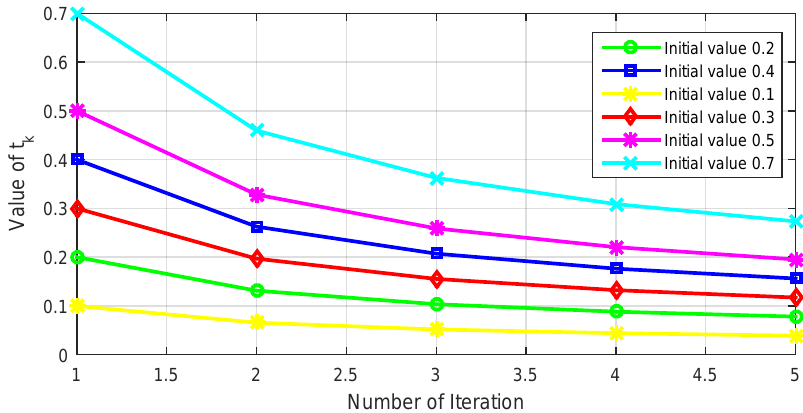
Figure 1. Graph corresponding to Table